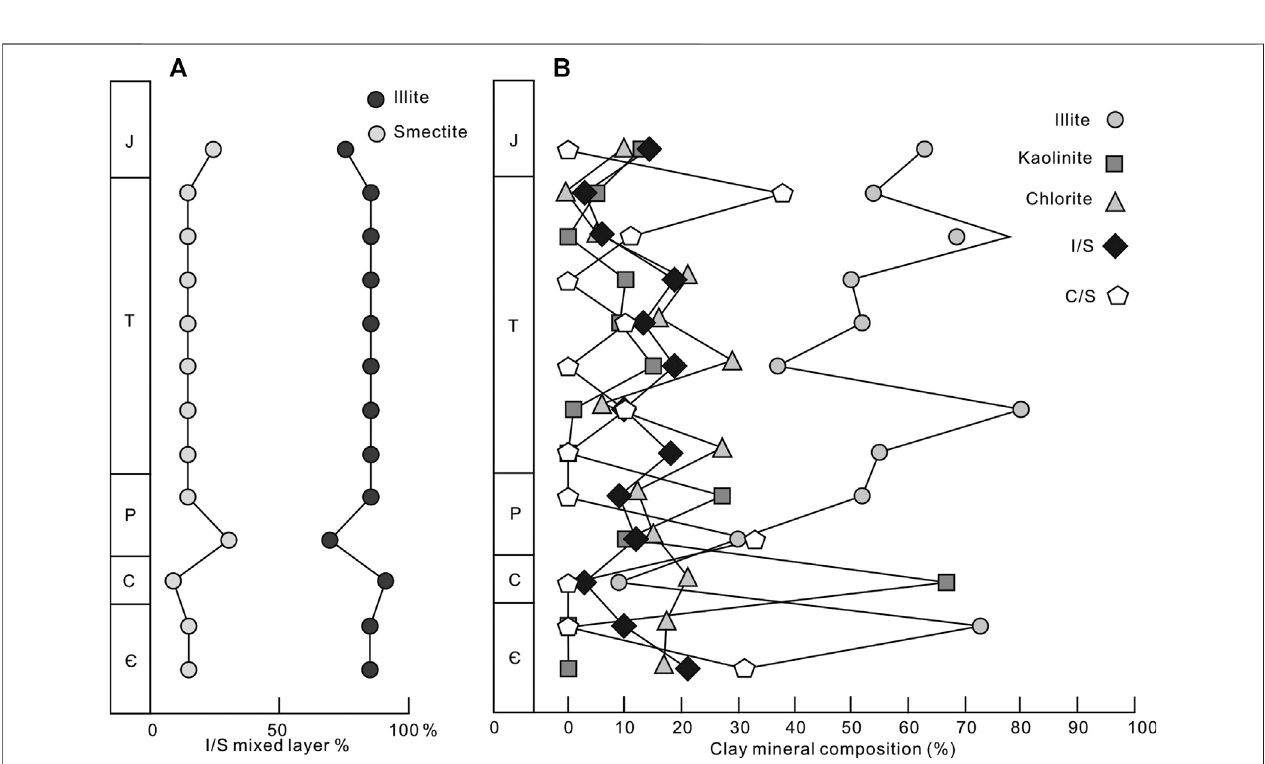
FIGURE5| Distributionofcrystallinityandclaymineralsmap (A) IllitecontentandstratumchangediagraminI/Slayer (B) Claymineralandstratumdistributiondiagram.